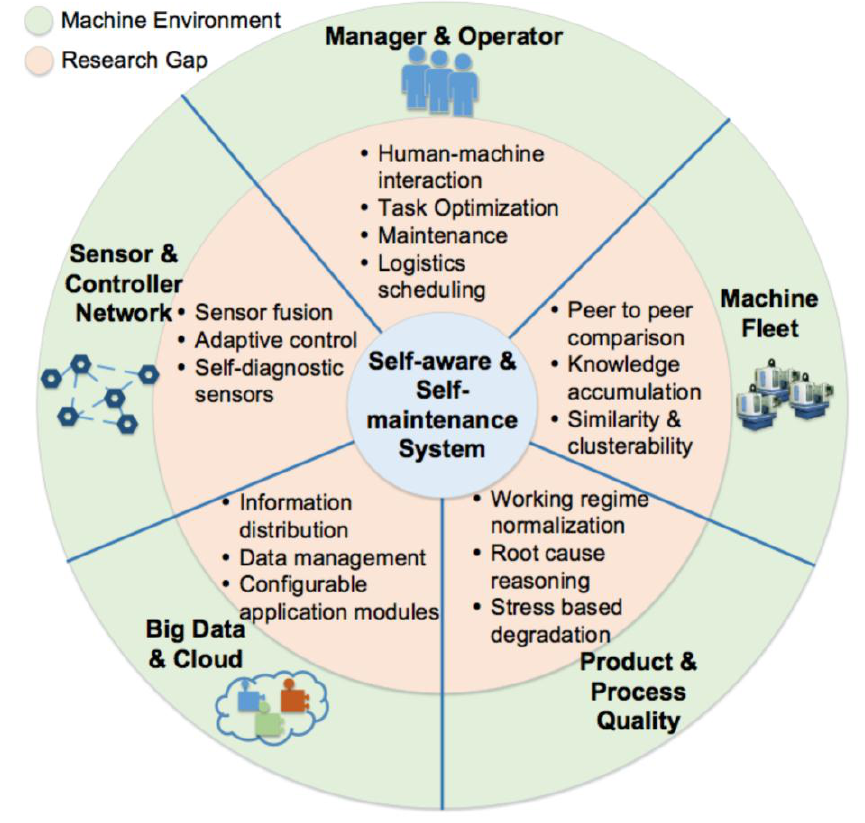
Figure 1. Research Gap of Self-aware and Self-Maintenance Machines in a Multi-dimensional